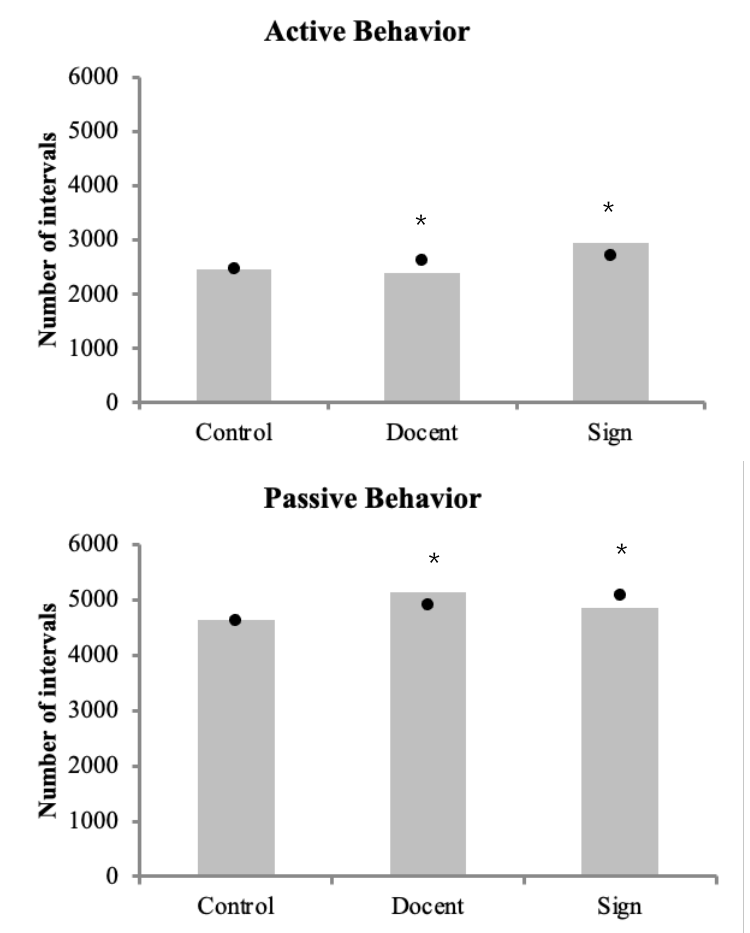
Active and Passive Behavior Across Visitor Conditions